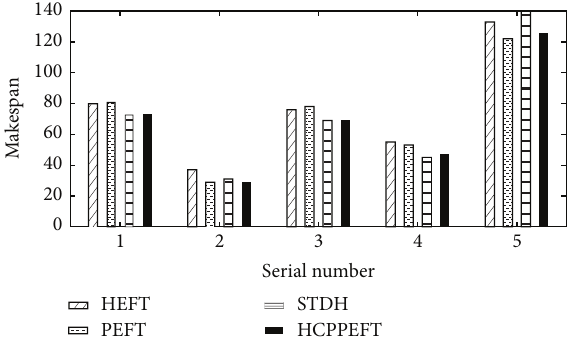
Figure 9: Makeapan with HCPPEFT, STDH, PEFT, and HEFT for the sets of task